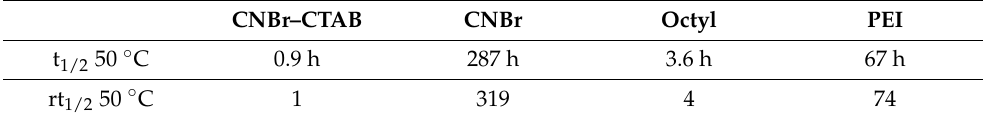
Table 3. Thermal inactivation of Lecitase derivatives: t 1/2 : half-life time of the inactivation (in hours); rt 1/2 : relative half-life, corresponding to the stabilization factor, i.e., t 1/2 divided by the one of CNBr–CTAB. Inactivation was carried out at 60 ◦ C and pH